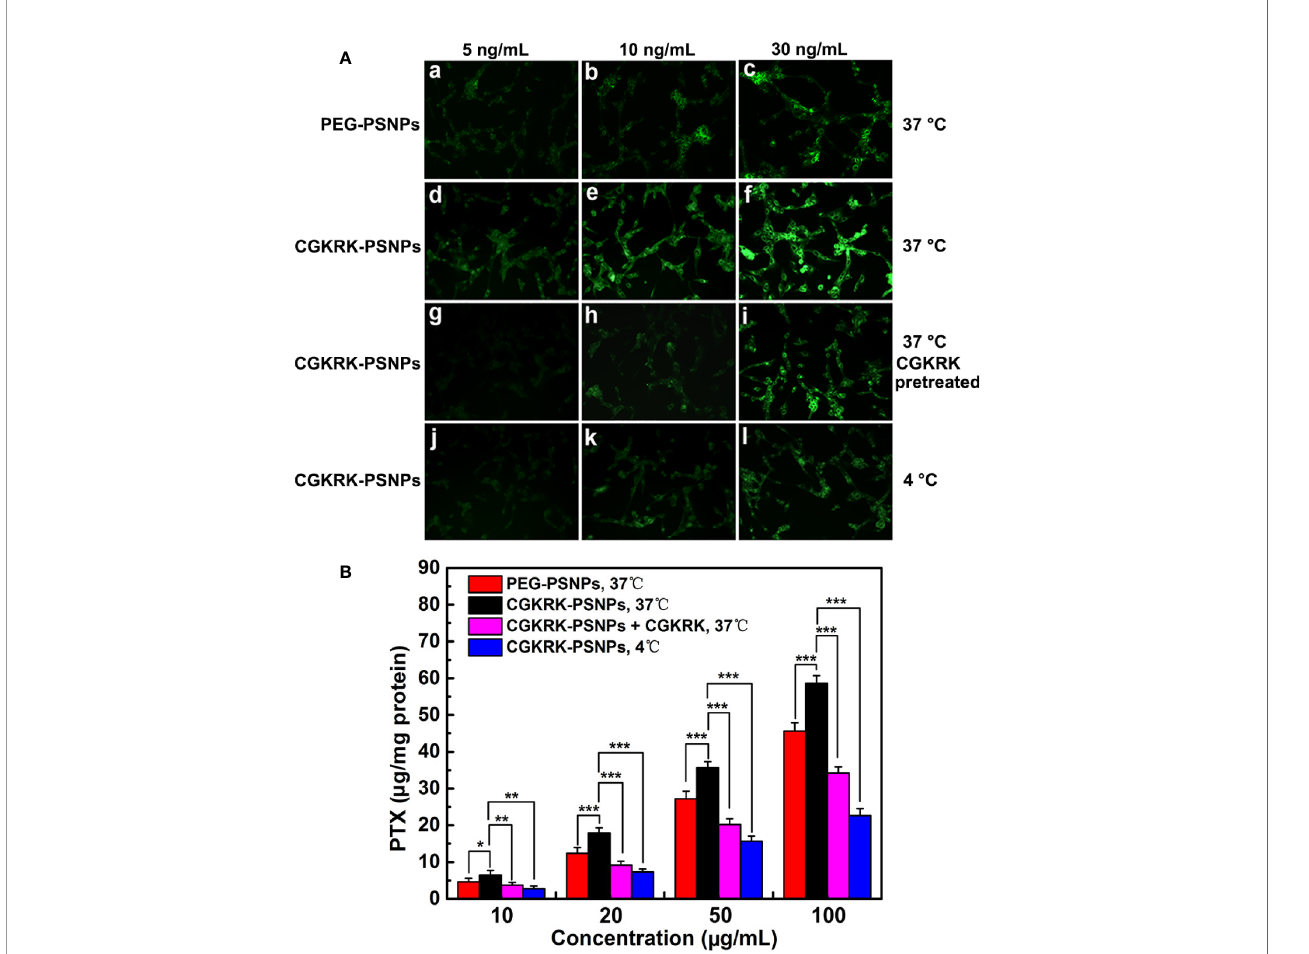
FIGURE 5 | Cellular uptake of coumarin-6-labeled PEG-PSNPs (a – c) and CGKRK-PSNPs (d – l) at 37°C (a – i) and 4°C (j – l) after incubation for 1 h at the coumarin-6 concentration of 5 (a, d, g, j) , 10 (b, e, h, k) , and 30 ng/ml (c, f, i, l) in U87MG and CGKRK pretreated U87MG cells (g – i) was examined by fl uorescent microscopy (A) . Original magni fi cation: ×20. U87MG uptake of PEG-PSNPs and CGKRK-PSNPs at different conditions after incubation for 1 h at the PTX concentrations from 10 to 100 m g/ml (n = 3) (B) . *** P < 0.001, ** P < 0.01, * P <